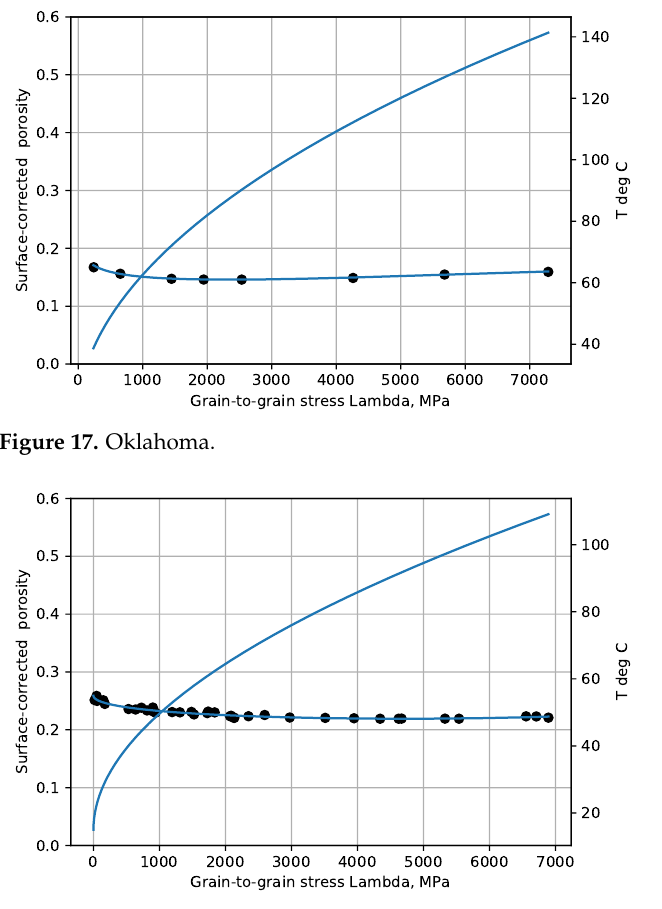
Figure 18. Maracaibo.